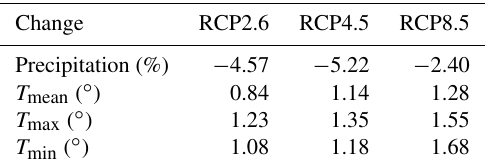
Table 1. Changes of precipitation and air temperature during the future 30 years under RCP